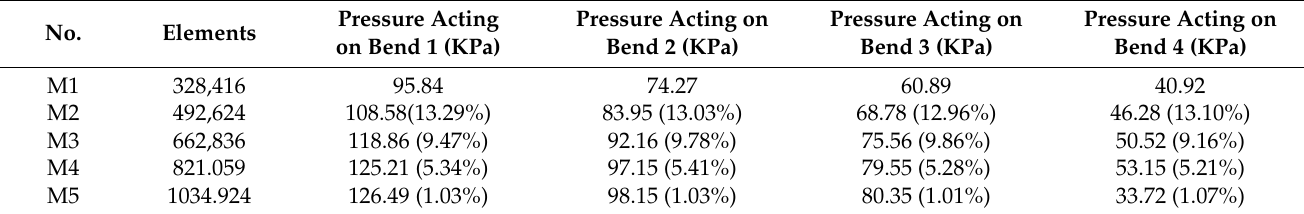
Figure 4. Computational mesh of both fluid and solid domains. Figure 4. Computa tional mesh of both fluid and solid domains. Table 2. Mesh independence Table 2. Mesh independence check.